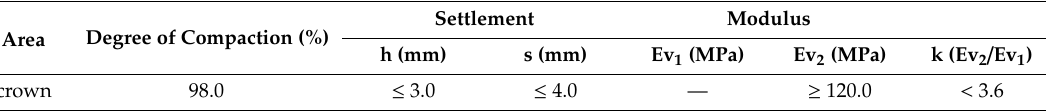
Table 4. General specifications suggested for crown random fills.